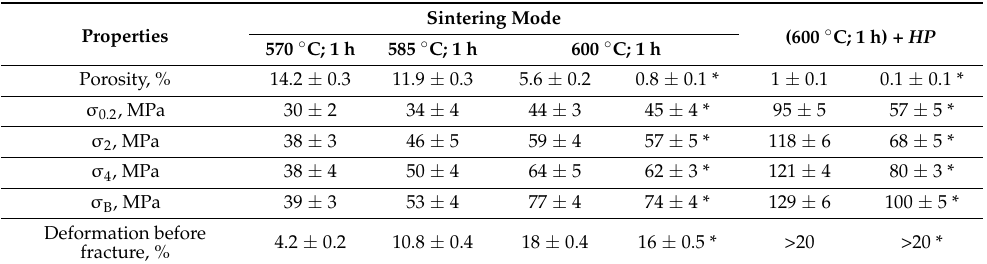
Figure 4. SEM images of the structure of (Al–10Zn)–40Sn ( a , b ) and Al–40Sn ( c ) CM; ( a ) after sintering at 600 ◦ C for 1 h; ( b , c ) after subsequent HP at 200 ◦ C. Table 2. Effect of the sintering mode and subsequent HP on the porosity and mechanical properties of (Al–10Zn)–40Sn